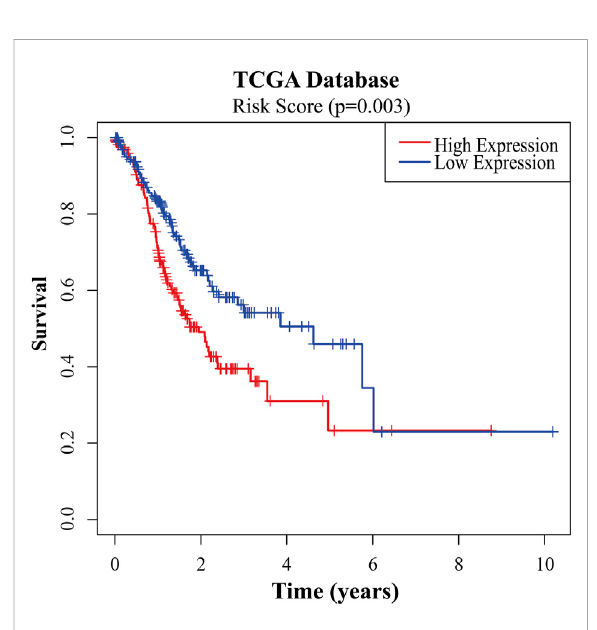
FIGURE 6 Survival analyses of the risk scores of key genes in TCGA database.